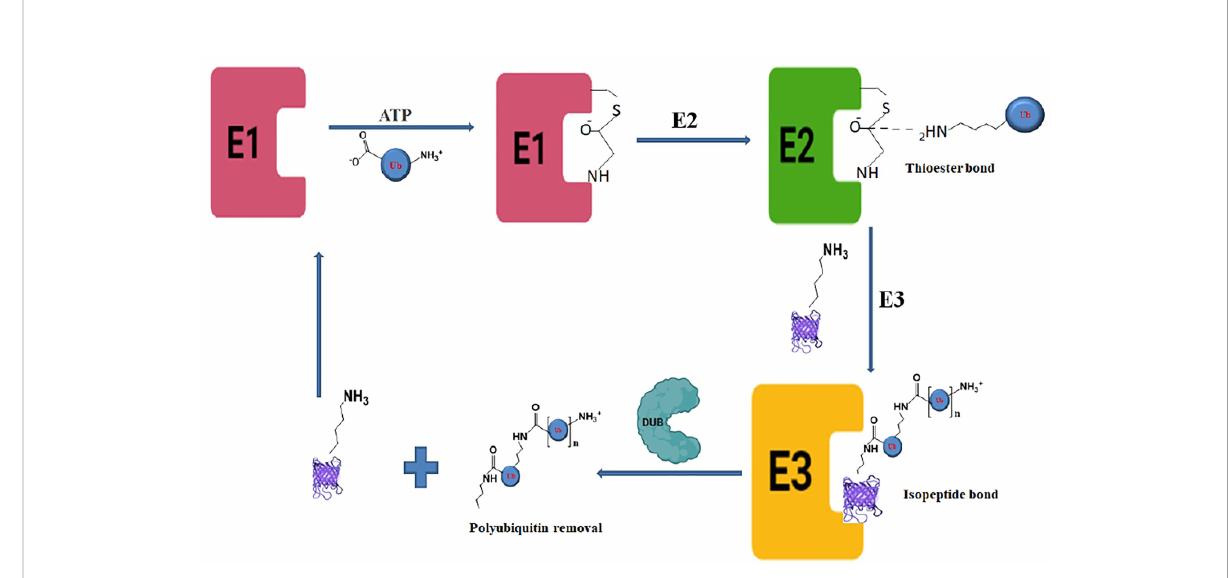
FIGURE 1 Biochemical pathway of ubiquitination and deubiquitination process showing the deubiquitinase enzyme activity in the last